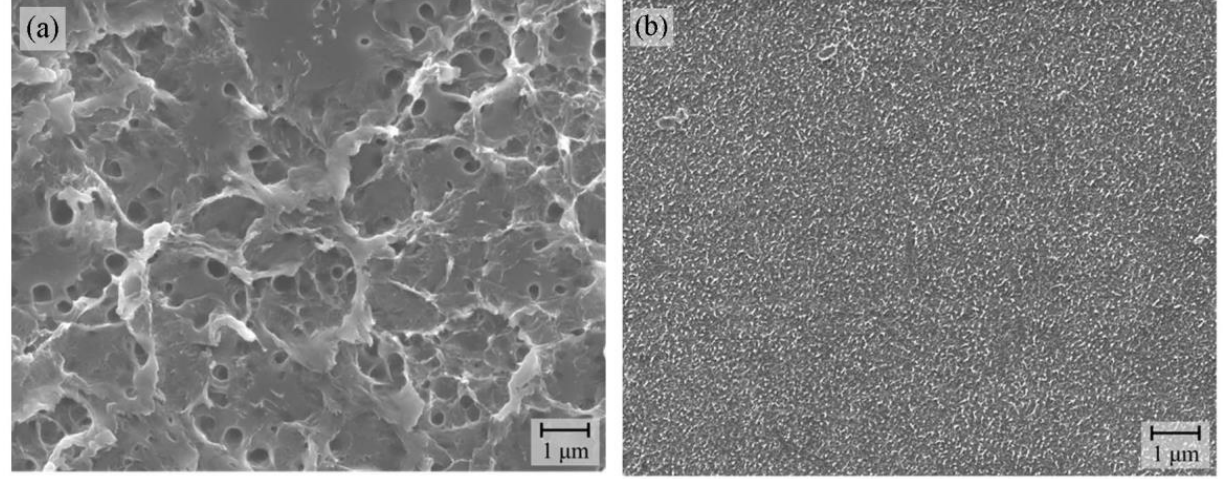
Figure 6. SEM images of substrates after peel electroless Cu plating. ( a ) Pd/ABS, ( b ) Pd/AS.